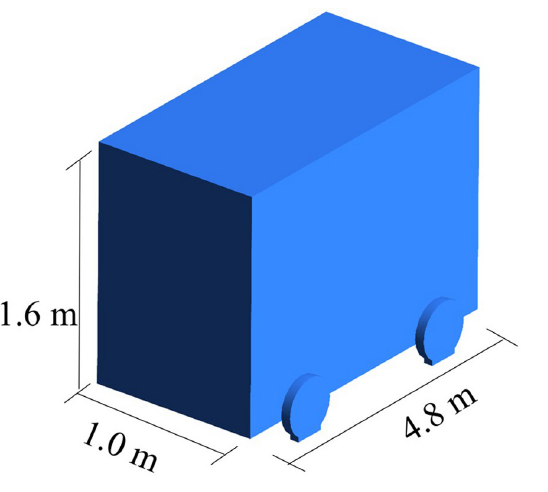
Fig 3. Mine-car dimensions.